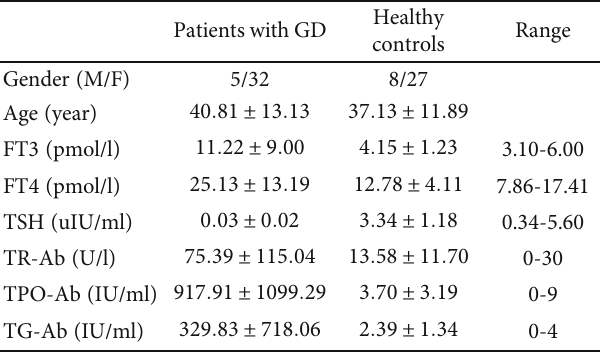
Table 1: Clinical features of the patients with GD and healthy controls included in this study. Healthy Patients with GD controls